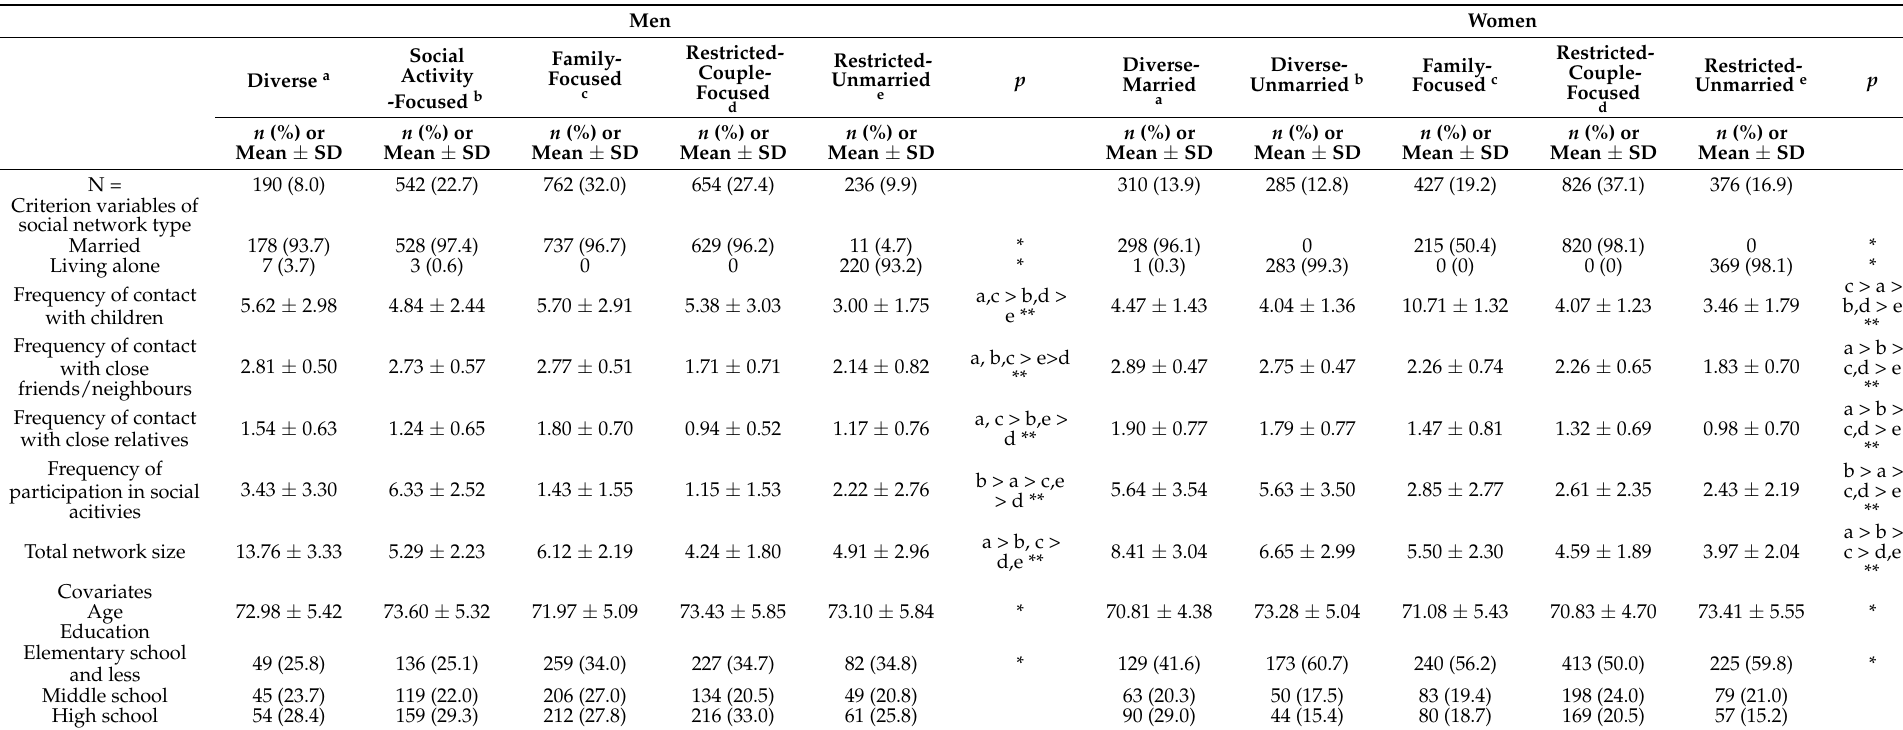
Table 3. Characteristics of the social network criterion, socioeconomic and health-related variables for each of the five social network types of older men ( n = 2384) and women ( n = 2224) in the 2017 Korean Living Profile Survey of Older